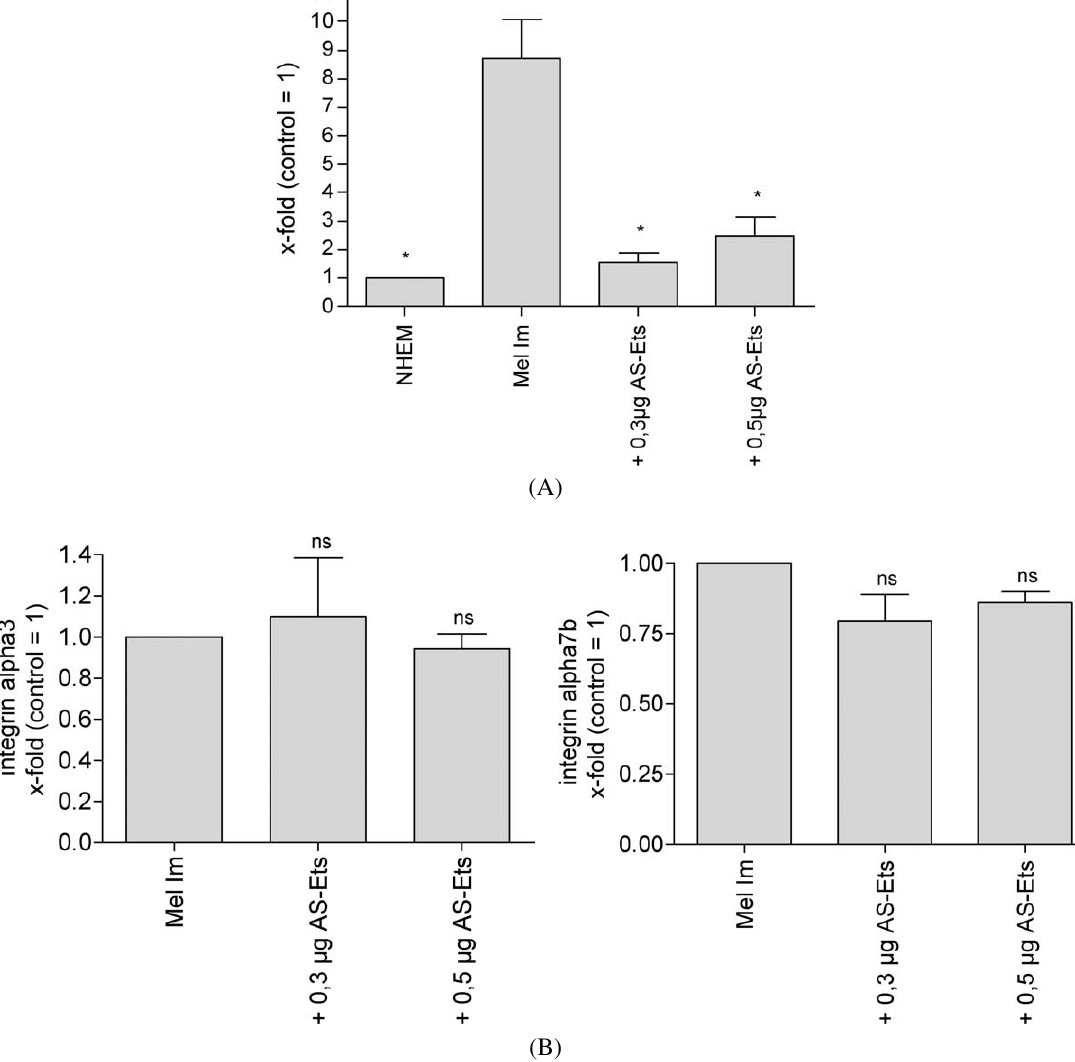
Fig. 2. Regulation of integrin alpha10 expression in antisense Ets-1 cell clones. (A) Integrin alpha10 mRNA expression in as Ets-1 transfected Mel Im cells was performed by quantitative RT-PCR. Clear downregulation of expression was found in melanoma cells with reduced Ets-1 expression (*: p < 0 . 05). (B) Expression of integrin alpha3 and integrin alpha7b mRNA in Mel Im cells transfected with as Ets-1. Expression is not regulated by Ets-1 (ns: not